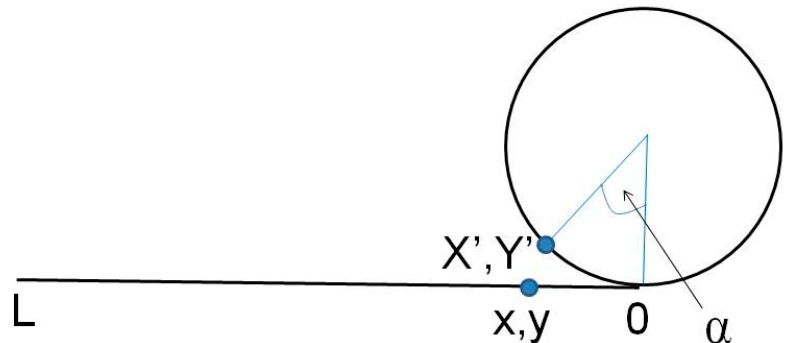
Scheme 1. Geometrical scheme representing the α angle in the transformation equations relative to the transformation of the (x,y) coordinates on a slab of length L to the (X’,Y’) values on a cylinder of diameter L/ π .